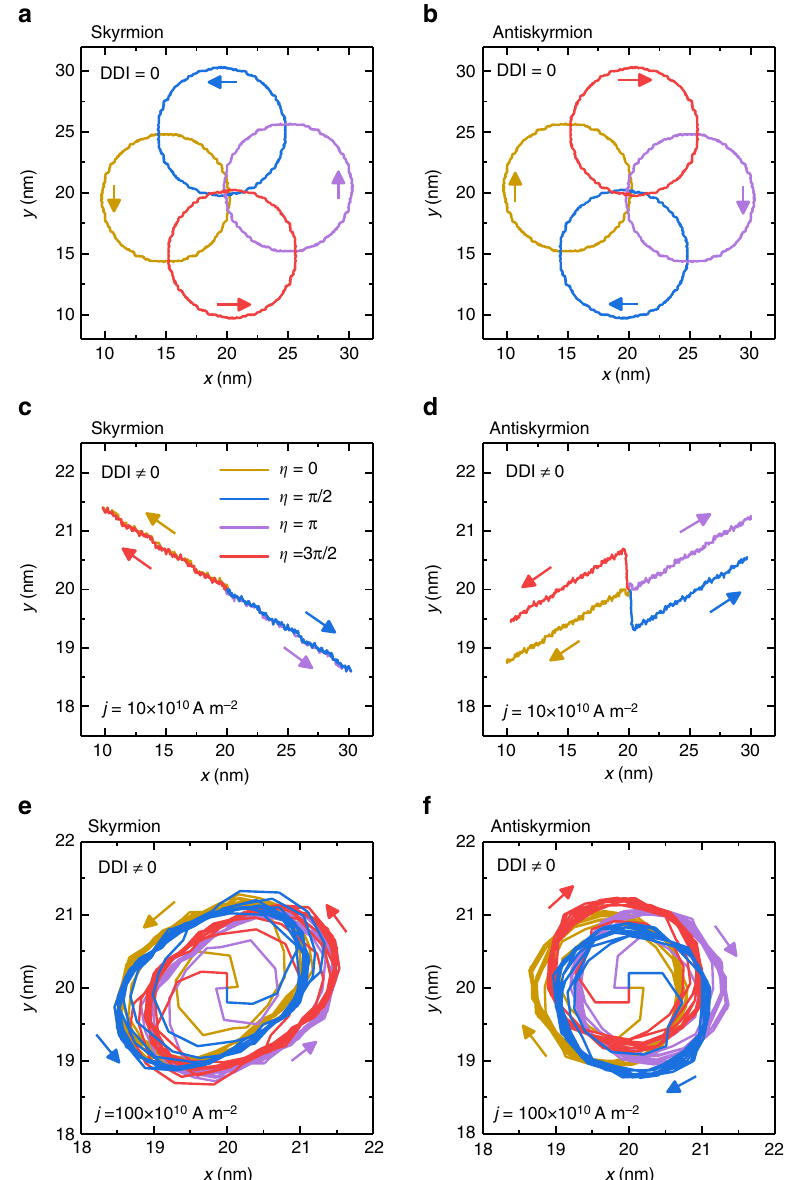
Fig. 6 Trajectories of skyrmions and antiskyrmions in a frustrated J 1 - J 2 - J 3 ferromagnetic thin fi lm. Trajectories of a skyrmions and b antiskyrmions with different initial η in the absence of the DDI. Trajectories induced by c , d a small driving current ( j = 10 × 10 10 A m − 2 ) and by e , f a large driving current ( j = 100 × 10 10 A m − 2 ) in the presence of the DDI. In the presence of the DDI, the skyrmion motion is along a straight line with the helicity fi xed for the small driving current, but it is along a circle together with the helicity rotation for the large driving current. This is the helicity locking-unlocking transition. The model is a square element (100 × 100 spins) with the OBC. The parameters are J 2 = − 0.8, J 3 = − 1.2, K = 0.1, H z = 0.1, and α =